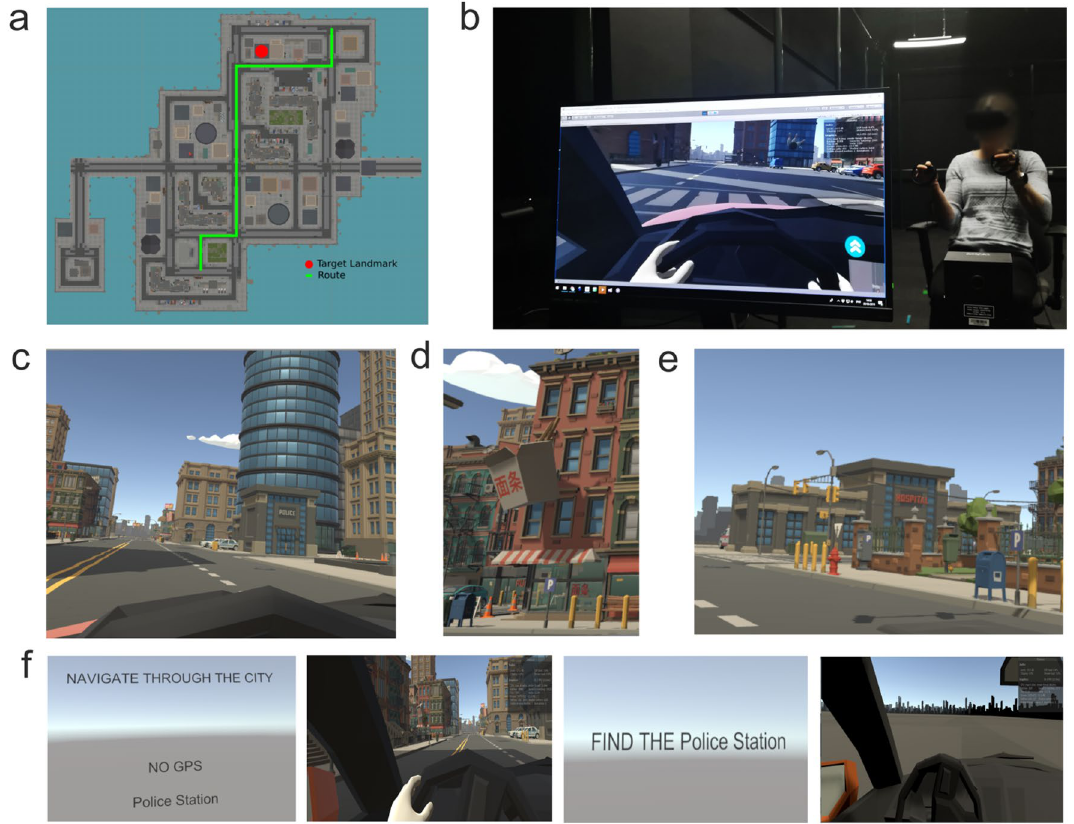
Figure 1. VR environment. ( a ) The top-down view of the IVR city environment with a route’s example (the route matches the trajectory in Fig. 2a). ( b ) The experimental setting. ( c – e ) Examples of target landmarks on the routes; “Police Station”, “Chinese Restaurant”, “Hospital” respectively. ( f ) Task representation and examples of participant’s view during the encoding and the test phase. In the example the participant was tested in the No GPS condition and was informed that the target he/she had to drive to at a later time was the police station (the route the participant drove through in this condition passed by the police station but did not stop there. During the test phase the participant was told by the screen to find the police station by driving in a blank city environment. To create Fig. 1. CorelDRAW 2020 (64-Bit) was used (https:// www. corel draw. com/ en/ pages/ corel draw-